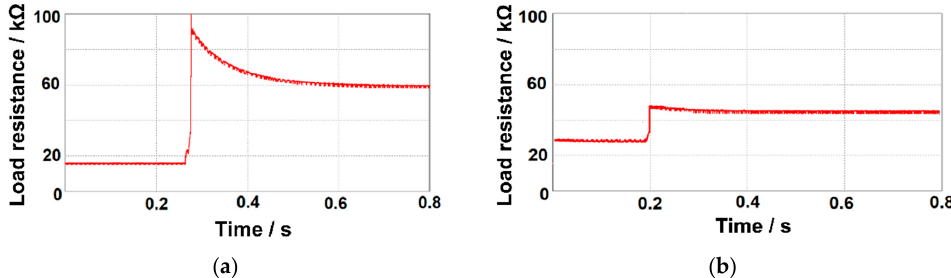
Figure 13. ( a ) Load resistance adaption (15–62 k Ω ) coping with a vibration frequency variation from 30 to 70 Hz; ( b ) load resistance adaption (28–46 k Ω ) coping with a PZT operating temperature variation from 25 to 50 ◦